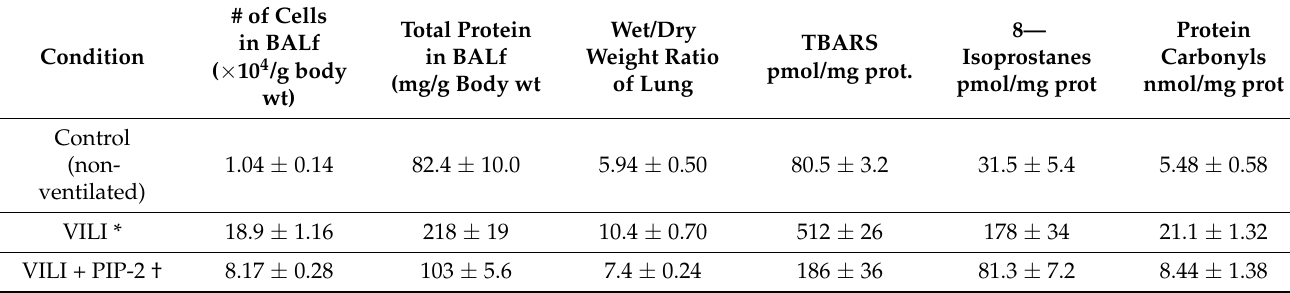
Table 4. Effect of intravenous (IV) PIP-2 on manifestations of VILI. Male mice were ventilated for 6 h with tidal volume of 12 mL/Kg, respiratory rate 120/min, PEEP 2 cm H 2 O. Control mice breathed normally (no mechanical ventilation). Mice were administered PIP-2 (2 µ g/g body weight) encapsulated in liposomes by IV bolus injection. Mice were sacrificed after 6h, and lungs were cleared of blood, lavaged, and processed as described in Materials and Methods. Results are mean ± SD for n = 4. * p < 0.05 vs. Control and vs. VILI+ PIP-2; † p < 0.05 vs. Control. Statistics represent all values in the indicated